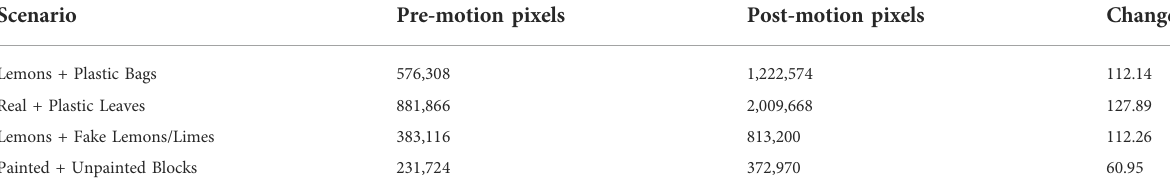
TABLE 1 Change in exposed anomalous pixels before and after application of pushing